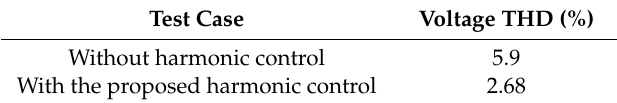
Table 4. Comparison of the output voltage THDs, with and without using the harmonic